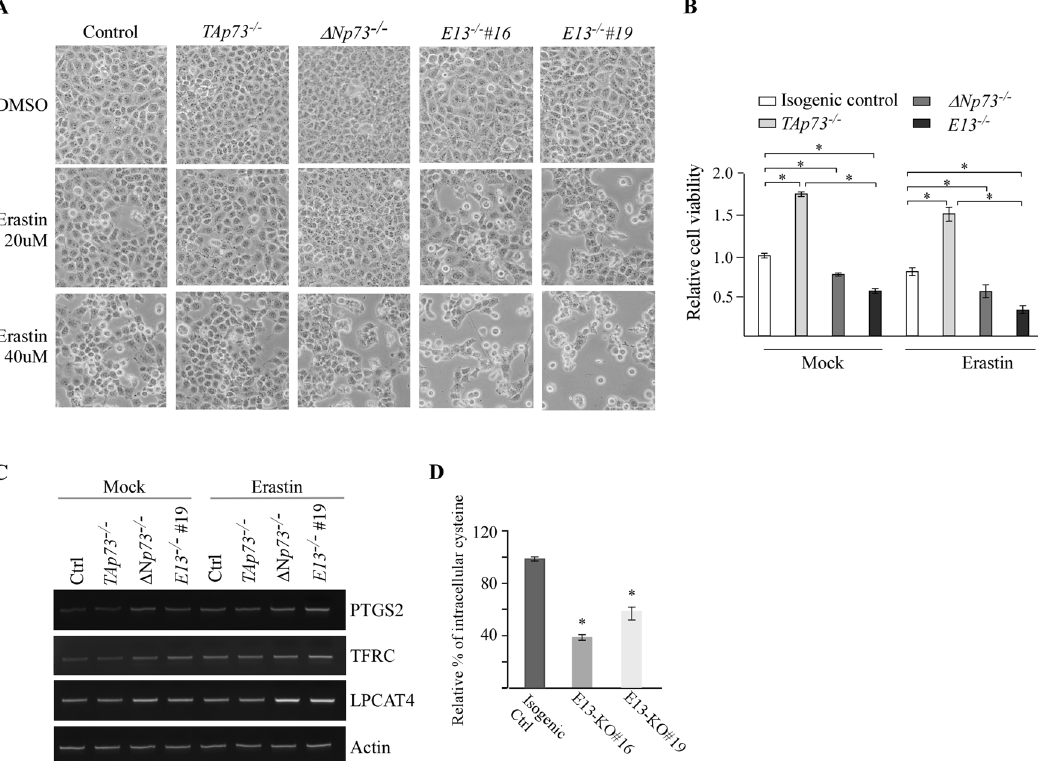
Fig. 4 Loss of E13 promotes ferroptosis. A Isogenic control, TAp73-KO, Δ Np73-KO and E13-KO H1299 cells were mock-treated or treated with Erastin for 8 h and representative microscopic pictures were taken to show cell morphology. B Cells were treated the same as indicated in ( A ), followed by CellTiter-Glo viability assay. Each treatment was performed in triplicates and data were presented as mean ± SEM. * p < 0.05 by student t -test. C Cells were treated the same as indicated in ( A ), followed by RT-PCR analysis to examine the levels of PTGS2, TFRC, LPCAT4 and actin transcripts. D The level of intracellular cystine was measured in isogenic control and E13-KO H1299 cells by Mass Spectrometric analysis. The analysis was performed in triplicates and data were presented as mean ± SEM. * p < 0.05 by student t